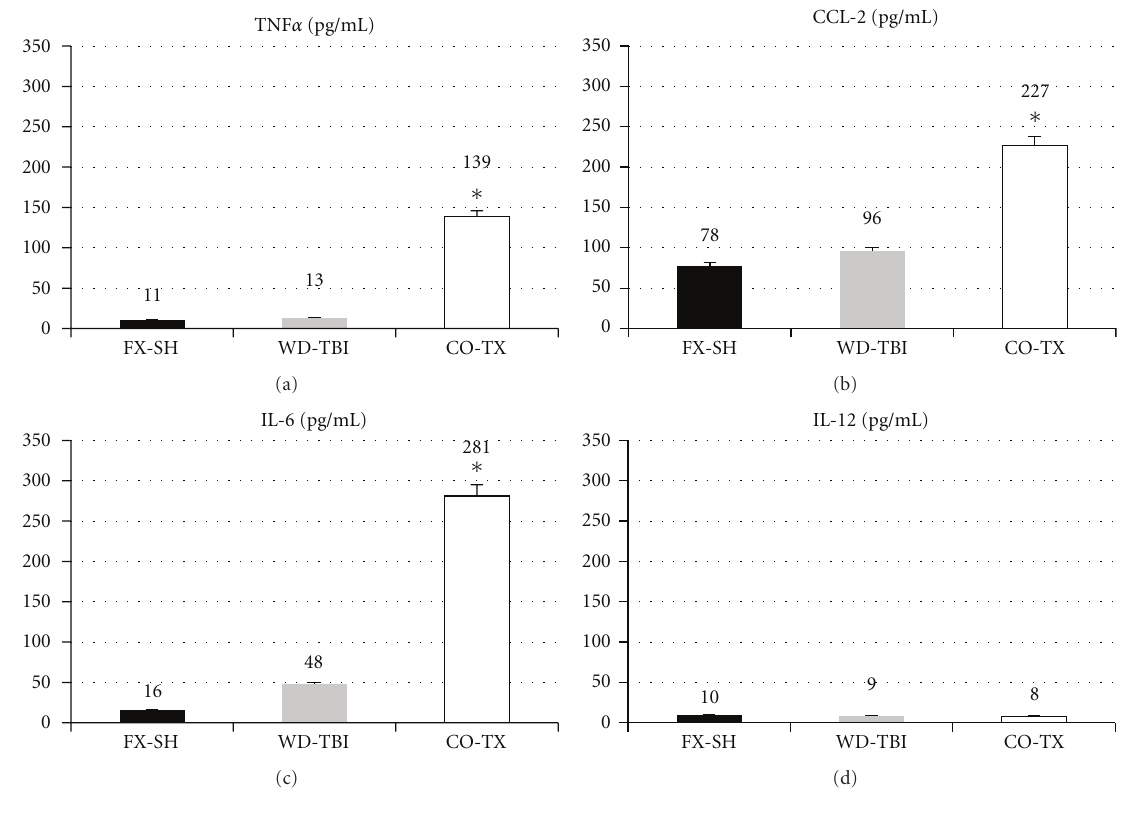
Figure 2: Cytokine levels (pg/mL) of the three subgroups. FX-SH: femur fracture and shock; WD-TBI: weight drop traumatic brain injury; CO-TX: combined injuries. ( ∗ ) P < 0 .